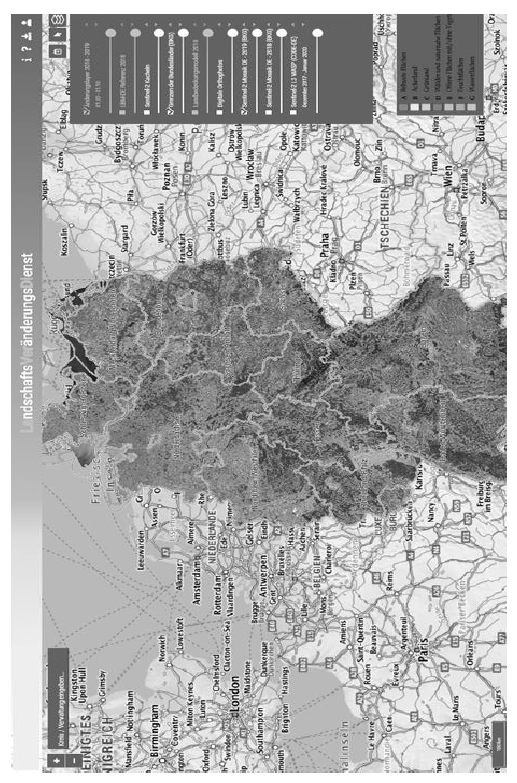
Figure 4 . Screenshot of the change detection viewer application. The developed front-end of the web application is based on the open-source framework Angular Material and the whole back- end programming has been implemented using ASP.NET Core. Communication between the front-end and back-end of the web application has been realised with WebSocket, whereas the communication between web application and the python back- end, representing the thematic processing chain on CODE-DE, is ensured via the open-source message broker RabbitMQ.